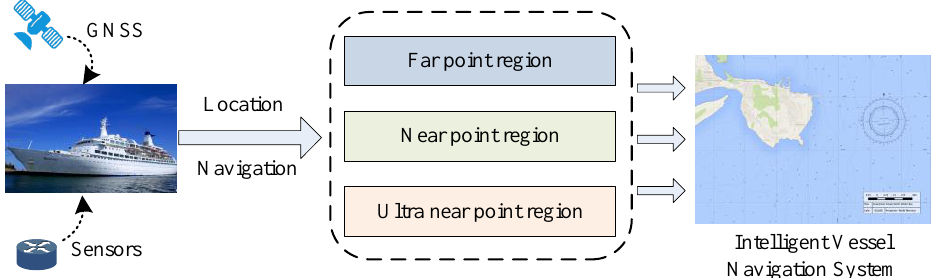
Figure 2. Survey line navigation methodological framework.